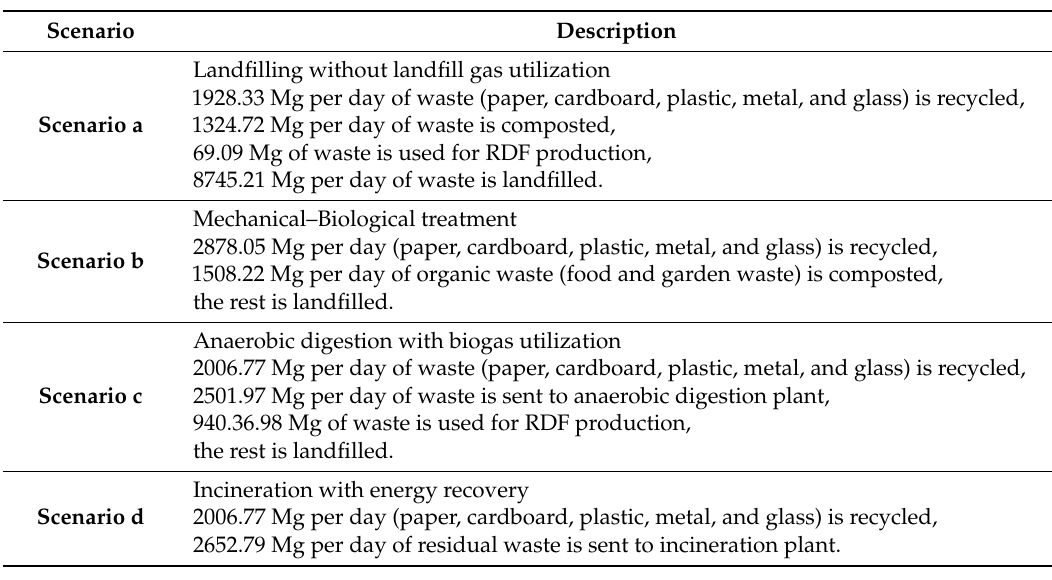
Figure 3. Mass flows of waste scenarios: ( a ) scenario with wet AD; ( b ) scenario in compliance with Norma 024. Table 1. Description of the discussed scenarios.